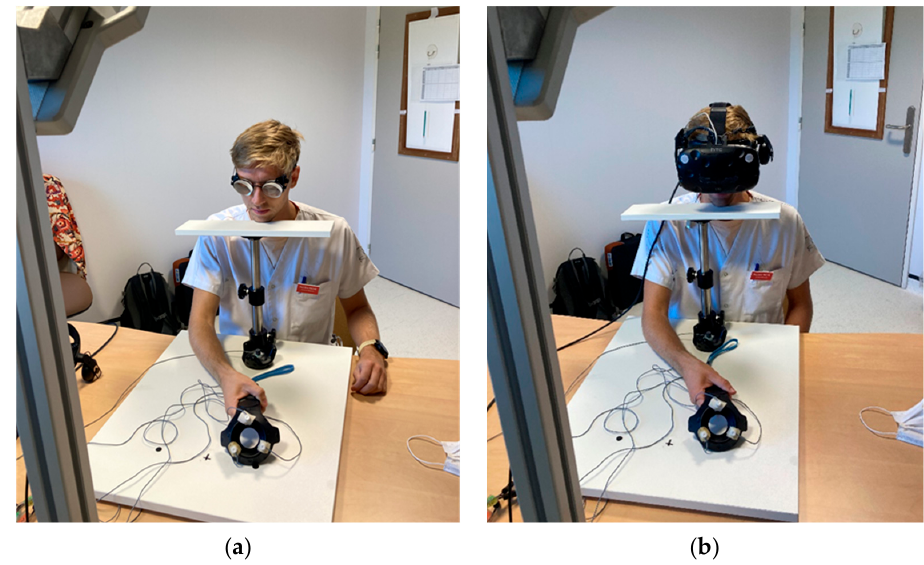
Participants randomly pointed at right or left targets 100 times without prismatic devia- tion. Figure 2. ( a ) Participant during exposure to real prisms; ( b ) Participant during exposure to virtual prisms.